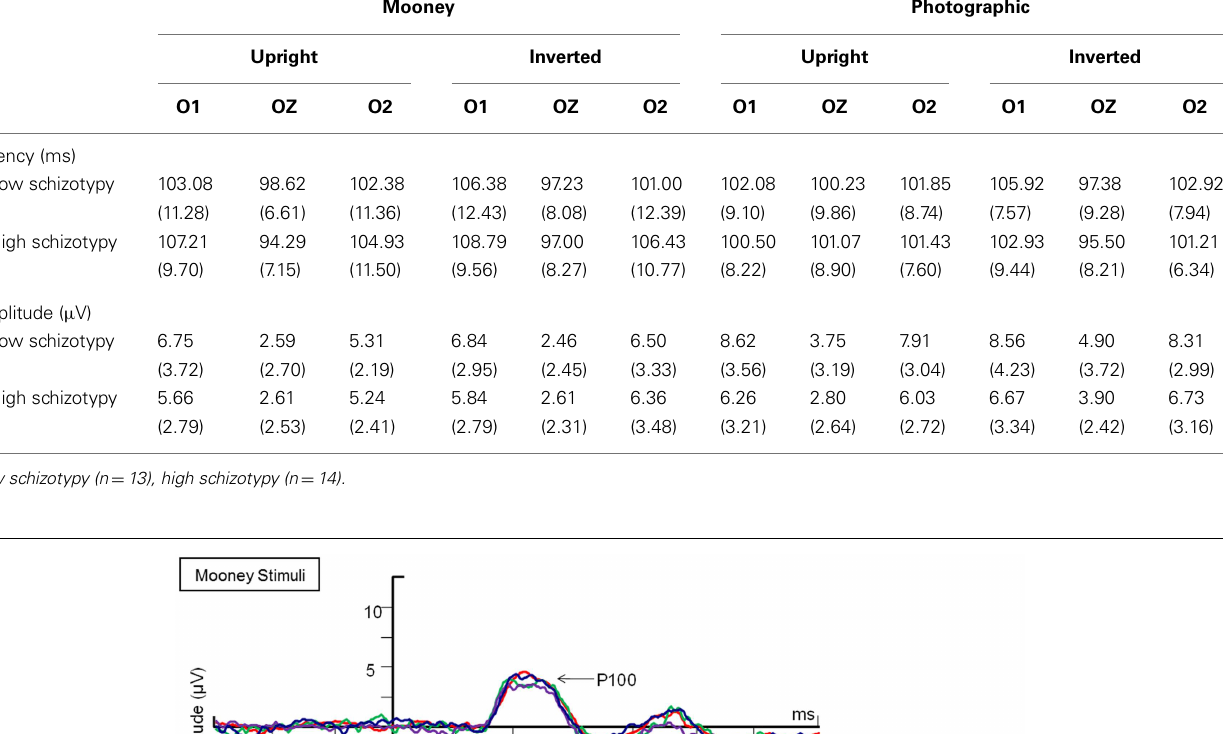
= 0.85. A task × orientation interaction demon- p < 0.001, η 2 p strated similar latencies to upright and inverted Mooney faces, whereas upright photographic faces were marked by earlier latencies relative to inverted photographic faces: F (1,26) = 8.83, = 0.85 (see Table 5 ). The left hemisphere p = 0.006, η 2 p showed earlier latencies ( M = 162.54 ms, SD = 9.54), than the right ( M = 163.50 ms, SD = 9.09) to upright faces, whereas this